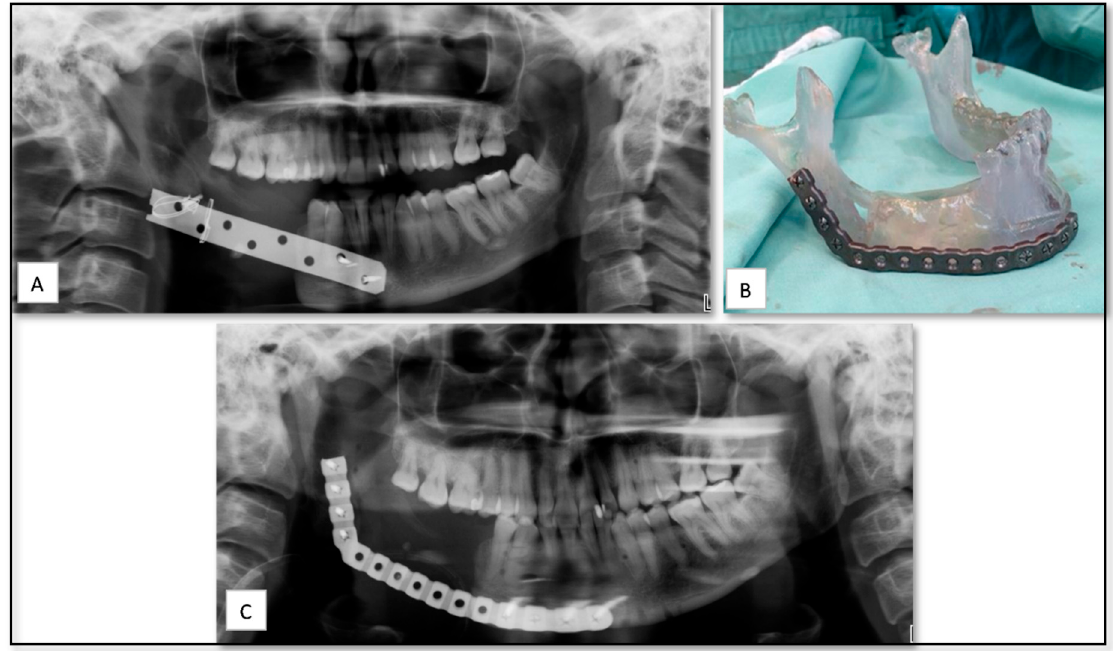
Figure 1. ( A ) Panoramic radiograph showing right mandibular defect with the old bone plate. ( B ) Stereolithographic (SLA) model and the prebent reconstruction plate. ( C ) Post-operative panoramic radiograph showing the installed reconstruction plate.